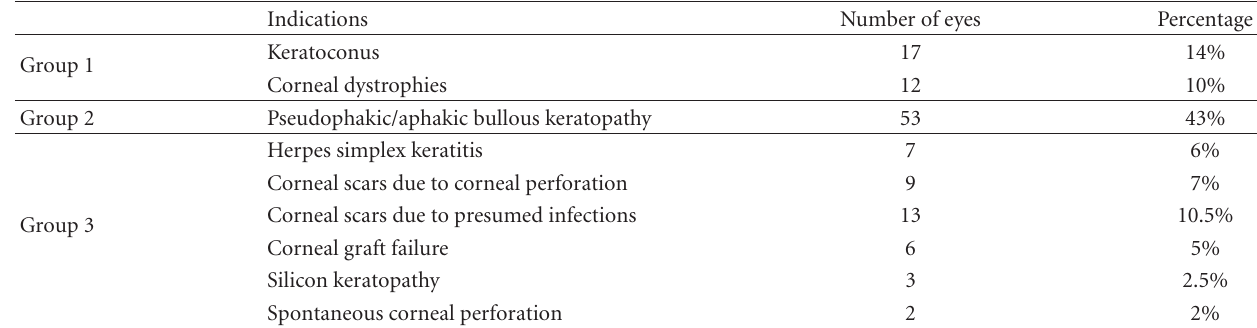
Table 1: Indications for penetrating keratoplasty.